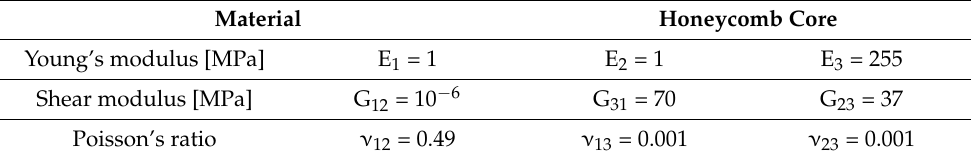
Table 10. Material constants used in the simulation of honeycomb core.